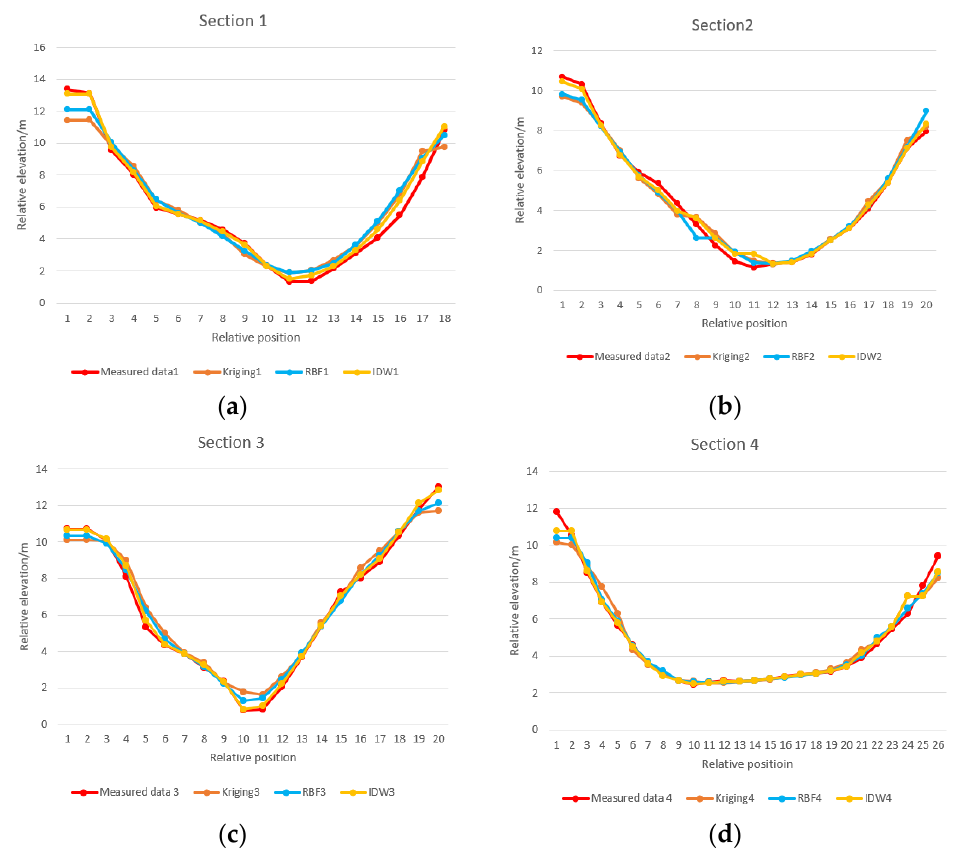
Figure 12. Comparison of interpolation results of different sections with the same interval spacing (10 m): ( a ) Section 1; ( b ) Section 2; ( c ) Section 3; ( d ) Section 4.